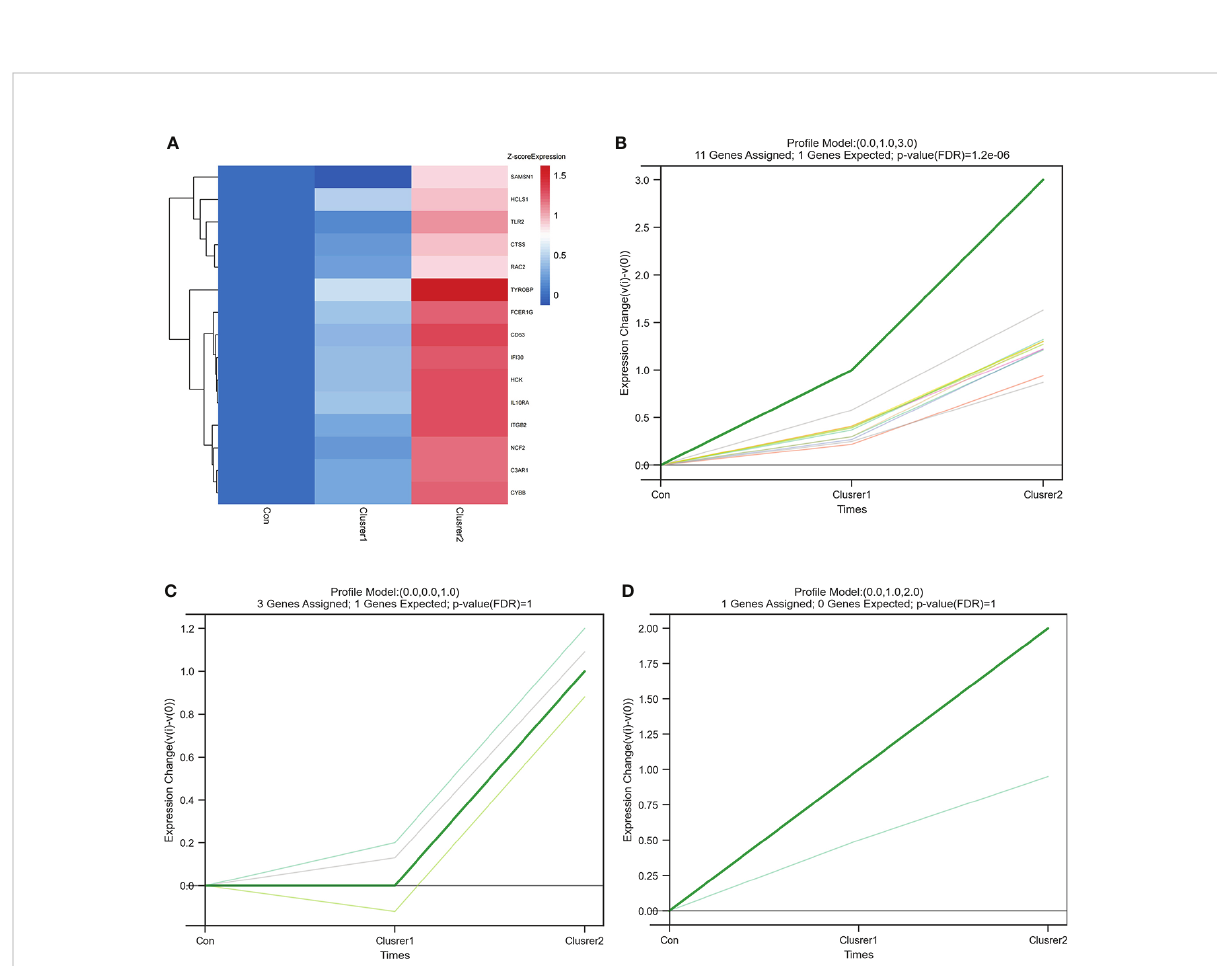
FIGURE 7 STEM analysis of 15 hub genes. (A) The heat map of 15 hub gene expression trends. In addition to SAMSN1, the expression of the other 14 hub genes increased gradually from control group to cluster 1 and then to cluster 2. (B) The line chart of six gene expressions in trend 1, including C3AR1, CD53, CTSS, CYBB, FCER1G, HCK, IFI30, IL10RA, ITGB2, RAC2, and TYROBP. (C) The line chart of six gene expressions in trend 2, including NCF2, SAMSN1, and TLR2. (D) The line chart of six gene expressions in trend 3, including